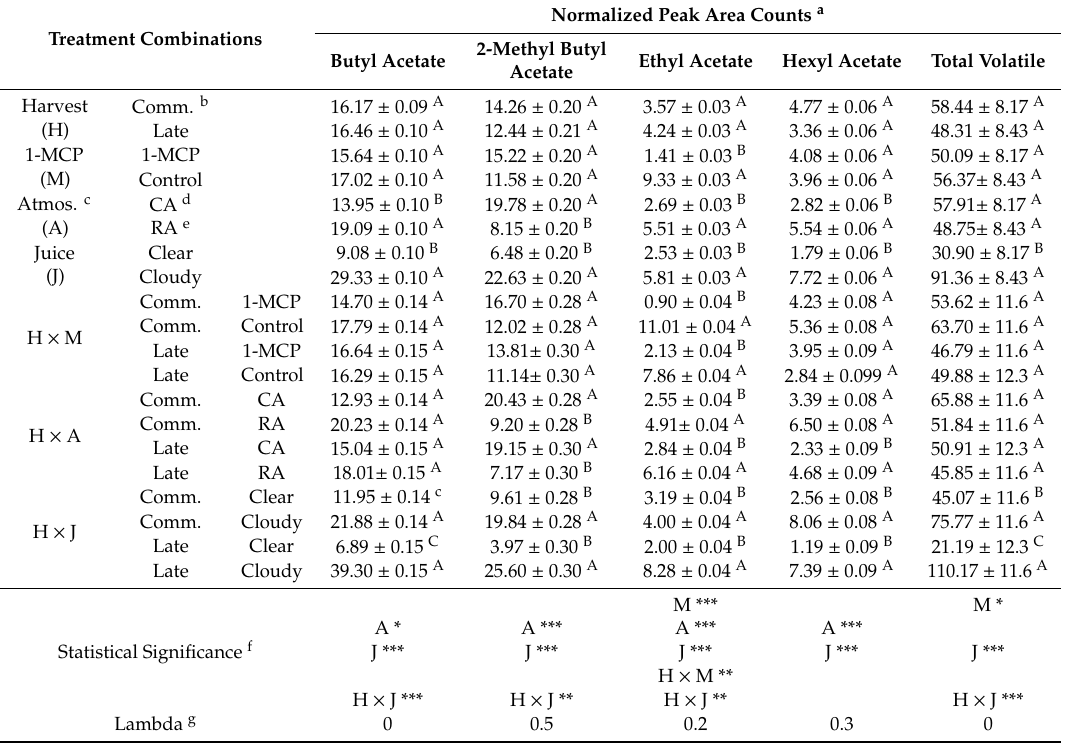
Table 4. Relative amounts of major ester volatile compounds identified in clear and cloudy juice samples from Honeycrisp apples harvested at commercial or late-harvest maturity, treated or untreated with 1-MCP and stored under CA or RA conditions for 4